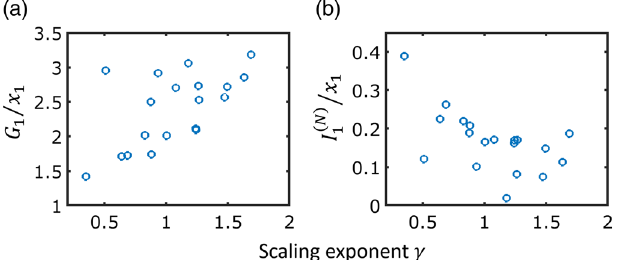
FIG. 10. Scaling exponents for different functional classes of genes, core genomes, and pangenomes. The class-specific pan- ð N Þ genome G 1 (a) and core genome I 1 (b) are plotted against the scaling exponent for E. coli . Each point corresponds to a functional class of genes. To allow comparison between classes, pangenomes and core genomes are normalized by the number of genes in each class. The plots show that the scaling exponent strongly and positively correlates with the class-specific pange- nome size but strongly and negatively correlates with the class- specific core genome size. Thus, for the sublinear classes, such as translation, the difference between the pangenome and the core genome is minimal, whereas for the superlinear classes, such as transcription, the pangenome dramatically exceeds the core genome, reflecting high